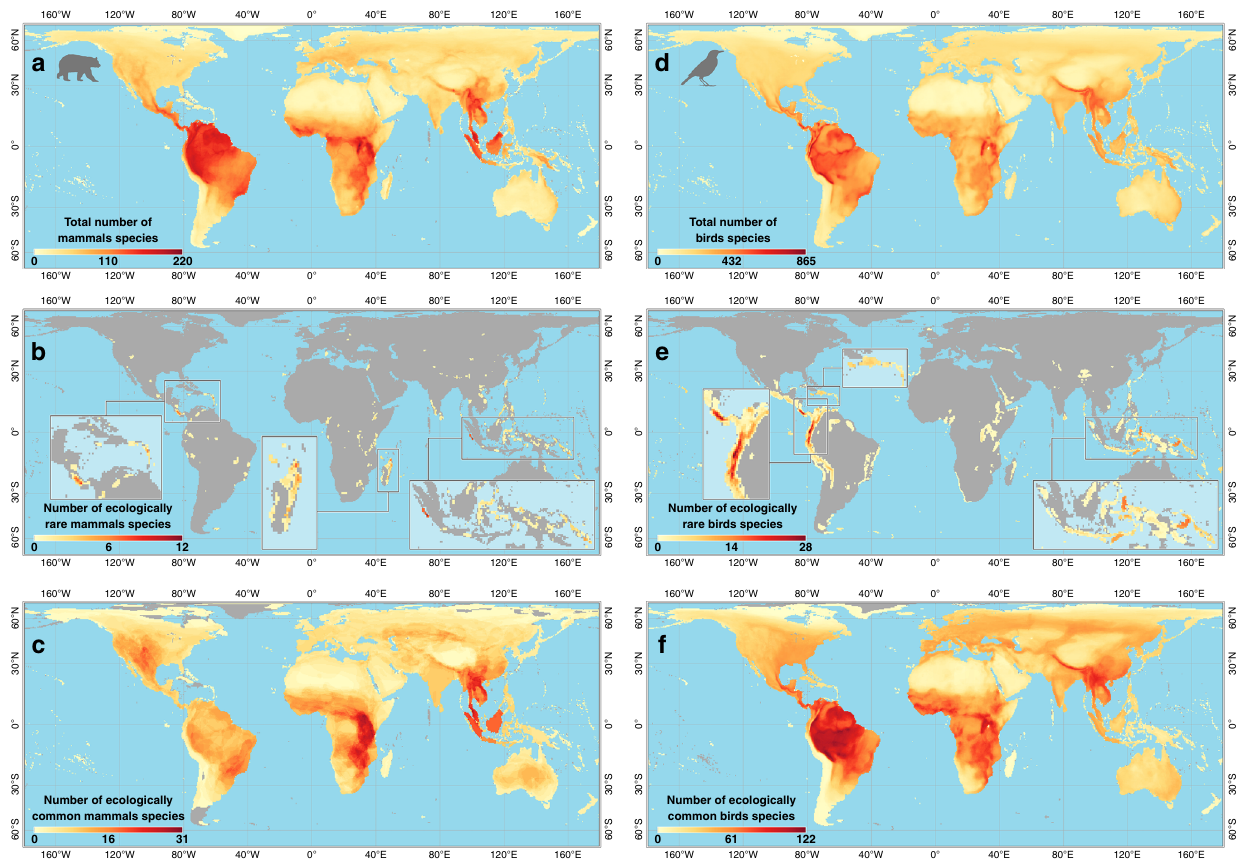
Fig. 4 Global distribution of mammal and bird species considering only unglaciated areas. a – c Distribution of total species richness, number of ecologically rare and common mammals, and d-f distribution of total species richness, number of ecologically rare and common birds. Icons were generated using R ( rphylopic package) and are under the Public Domain Dedication 1.0